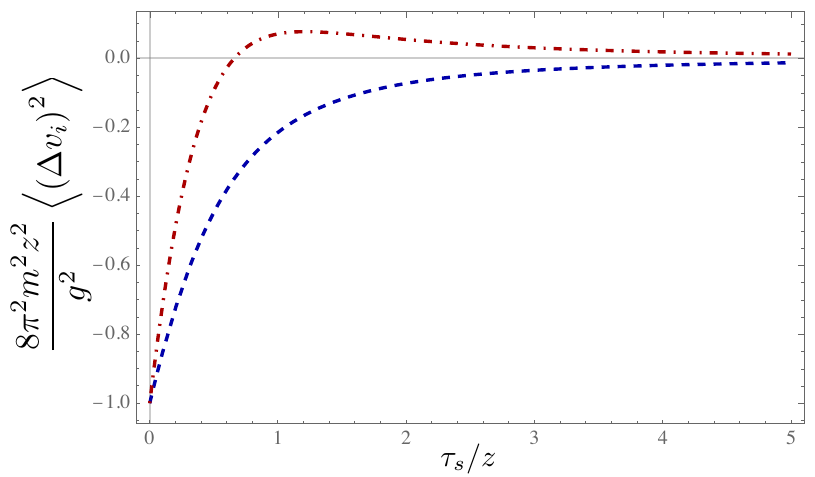
Figure 6 . Behavior of the dispersions of parallel (dashed curve) and perpendicular (dot-dashed curve) components of the particle velocity when the switching F (cid:28) regime (cid:28) is taken. Subindex i holds for parallel ( ! 1